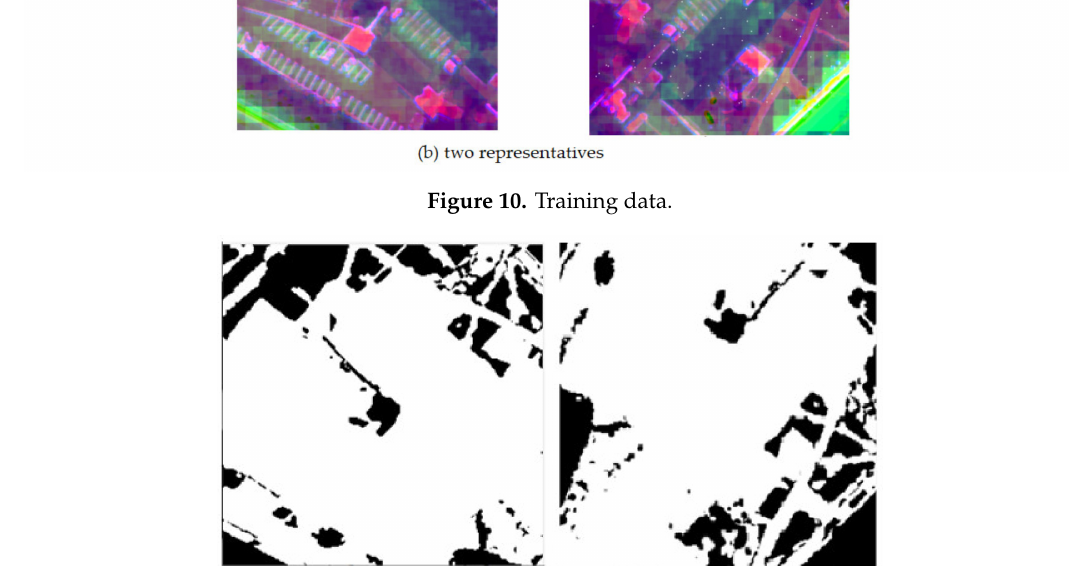
Figure 11. Two representatives in 1000